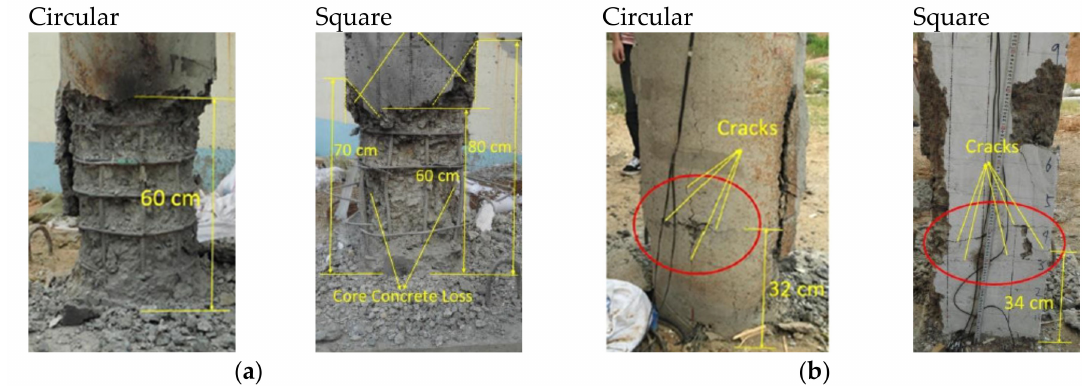
Figure 13. Comparison of damages of circular and square RC columns after the detonation of 1 kg of TNT: ( a ) front side and ( b ) back side [23]. Copyright permission obtained from